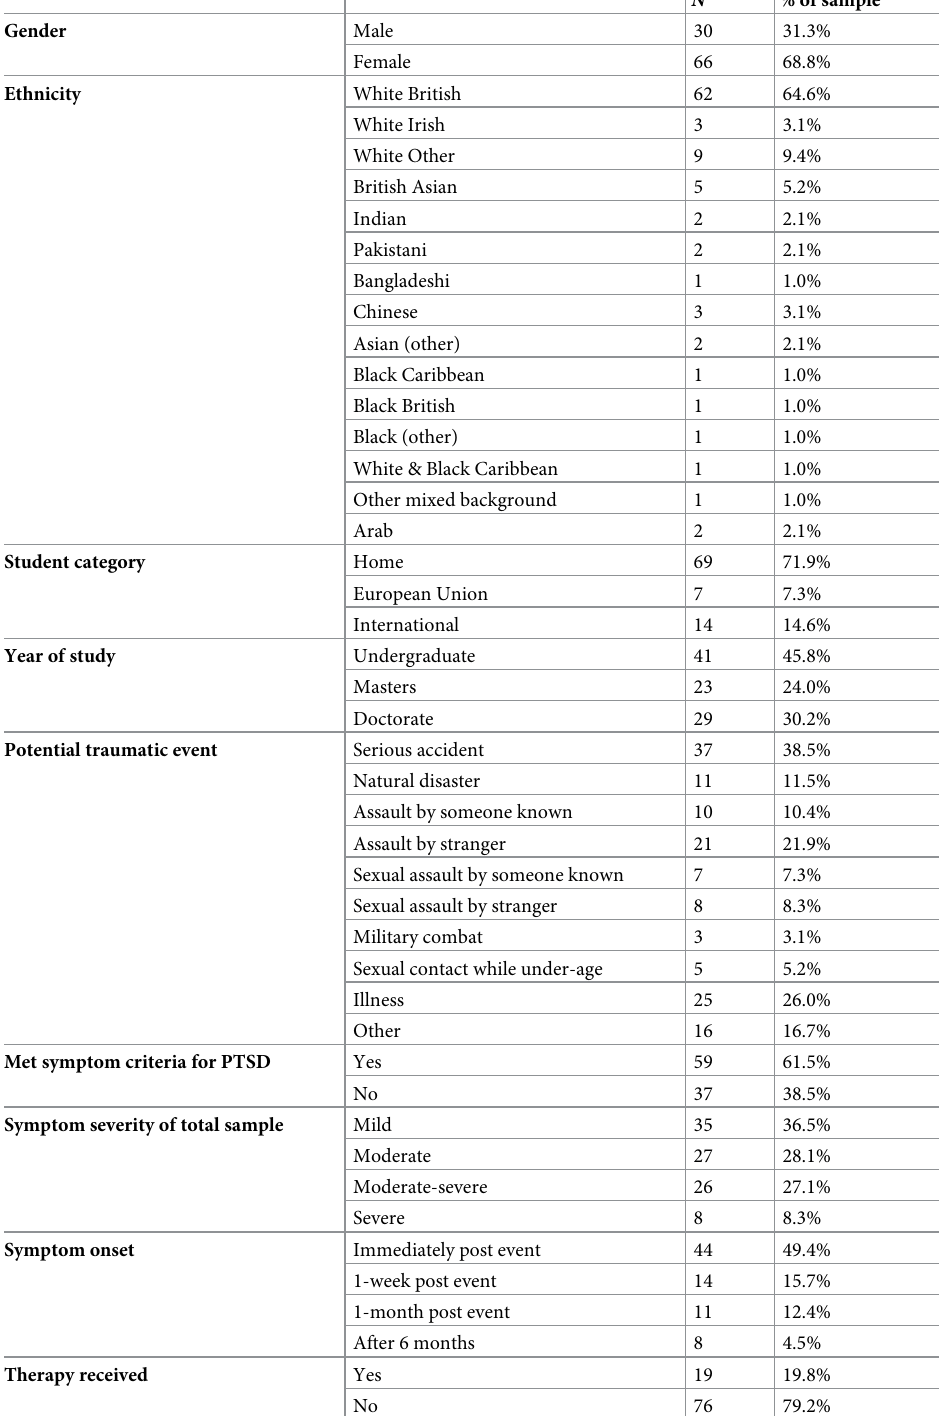
Table 1. Description of participant demographics and trauma